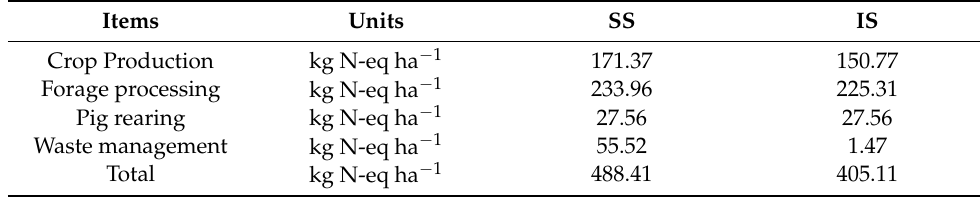
Table 5. NF of the separated and integrated crop-swine